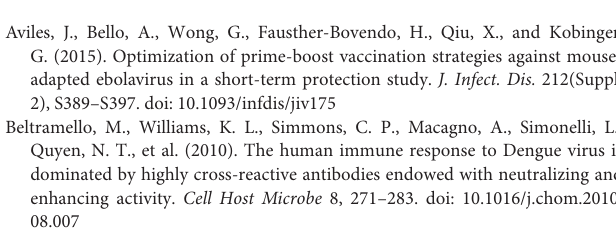
FIGURE S1 | Characterization of amino acid residues and in vitro expression of cE80. (A) Distribution of predicted amino acid residues along the cE80 sequence aligned with DENV1–4 E80 proteins. Line 1 (number), residue positions; Line 2 (red rhombuses), predicted protein binding region; Line 3 (dark red and blue bars), dark red bar represents helix and blue bar represents strand; Line 4 (blue, white and yellow bars), blue bar represents the region exposed on the surface, white and yellow bars represent intermediate and buried regions; Line 5 (green bar), disordered regions. The predicted features were created by an online website (http://open.predictprotein.org/). (B) In vitro expression of cE80. BHK-21 cells were transfected with recombinant plasmid pV-cE80. Transient expression of cE80 protein was examined by indirect immunofluorescence assay. After fixation with paraformaldehyde, the cells were permeabilized with 0.3% Triton X-100 in phosphate buffer solution and then blocked with bovine serum albumin. Immune sera obtained from mice infected with DENV1, 2, 3, or 4 were used as the primary antibodies. Cells were stained with goat-anti-mouse IgG-FITC (in green) and counterstained with DAPI (in blue) to identify cell nuclei ( × 200). The white bar represents 50 µ m. FIGURE S2 | Gating strategy for T cell subsets in splenocytes. Cells stained with different combination of antibodies were sequentially gated. First, gated on the life cells (FSC area vs. SSC area, left). Second, gated on single cells (FSC width vs. FSC area, middle). Finally, gated on CD3 + CD8 + T cell (right). TABLE S1 | Homologous alignment of cE80 with different serotypes of DENV at nucleotide and amino acid level. DENV, dengue virus; AA, amino acid. a Standard strains. TABLE S2 | Immunization groups and schedule. i.m., intramuscularly; s.c., subcutaneously; EP, electroporation. TEXT S1 | Sequence of